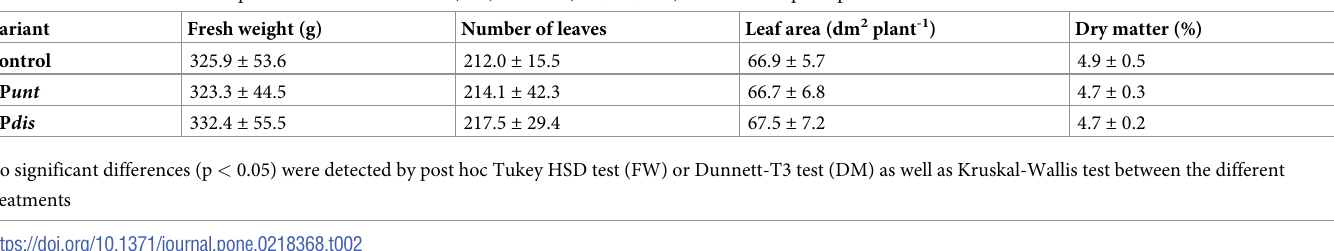
Table 2. Growth parameters of butterhead lettuce grown in nutrient solution formulated with fresh water (control: 50:50, v/v fresh and rain water), fish water (untreated, AP unt ) and disinfected fish water (AP dis ). The fresh weight (FW), number of leaves (LN), leaf area (LA), and dry matter were compared and tested using univariate ANOVA. The data represent mean values of ten (FW) or three (LN, LA, DM) lettuce heads per repetition of each treatment. Variant Fresh weight (g)